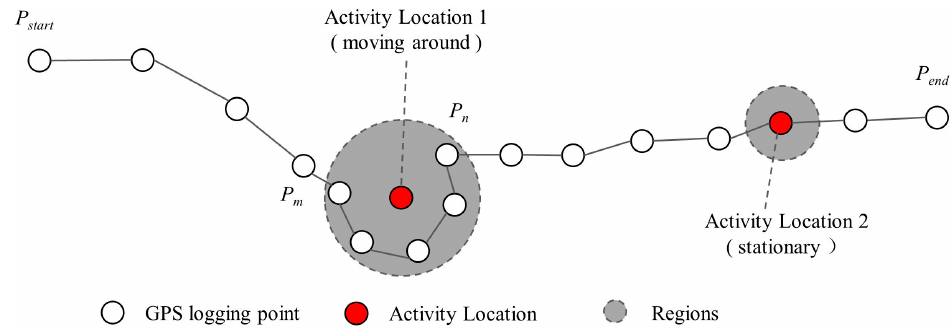
Figure 3. Extracting activity locations from GPS trajectory.